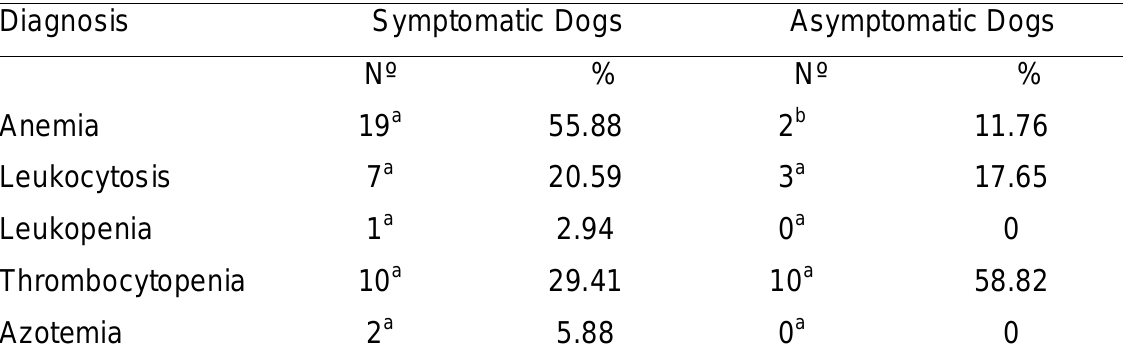
Table 4: Complete blood count and serum biochemistry in symptomatic (n=34) and asymptomatic (n=17) nonazotemic VL seropositive dogs from Teresina, Piauí State, Brazil, 2002.